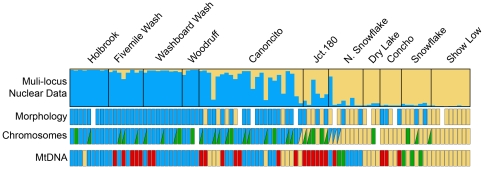
Population structure contrasted across character types.Estimated population structure across the hybrid zone based on the Structure analysis (K = 2) of the 12 nuclear loci. Each bi-colored vertical bar represents the estimated membership fraction of an individual into two population clusters. Assignments based on morphology, chromosomes, and mtDNA haplotypes are shown for comparison. Missing bars indicate missing data.